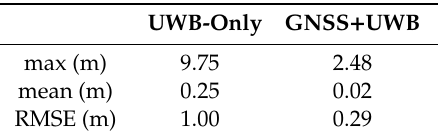
Table 8. Overall vertical positioning error.